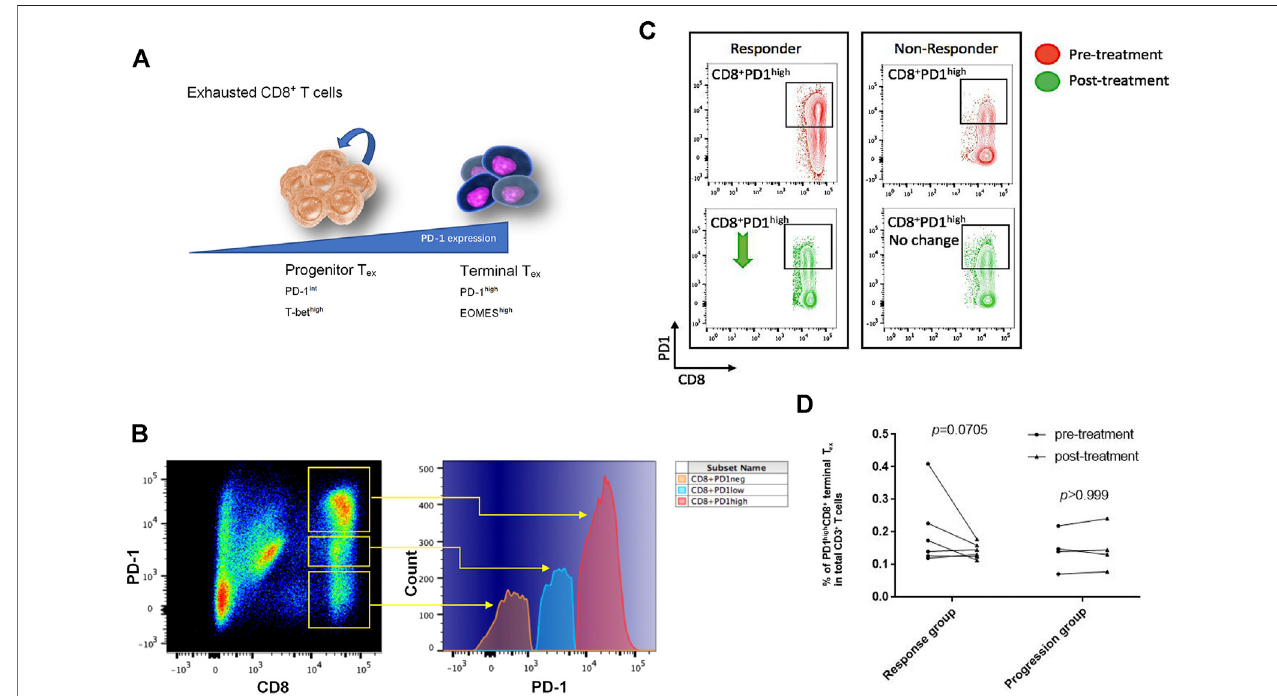
FIGURE 2 | CD8 + PD-1 high T cells decreased for responding to PD-L1 blockade treatment. (A) The CD8 + PD-1 high subset was identi fi ed as terminal exhausted T cells,whichhighly expressed theEOMES transcriptionfactor, while CD8 + PD-1 int/low population that expressed theT-bet transcription factor wasknown asprogenitor exhausted T cells (Wherry and Kurachi, 2015). (B) According to the log-density plot of the PD-1 expression level, three subsets of CD8 + T cells were found in Chinese non – small-cell lung cancer patients ’ peripheral blood. There were PD-1 high , PD-1 low , and PD-1 neg CD8 T + cells. (C) Two representatives illustrated that the percentage of CD8 + PD-1 high T cells in the response group decreased, whereas it did not have an apparent change in the progression cohort after PD-L1 blockade treatment. (D) ThepercentageofCD8 + PD-1 high Tcellsineachpatientbeforeandaftertreatment( p (cid:2) 0.0705intheresponsegroup; p >